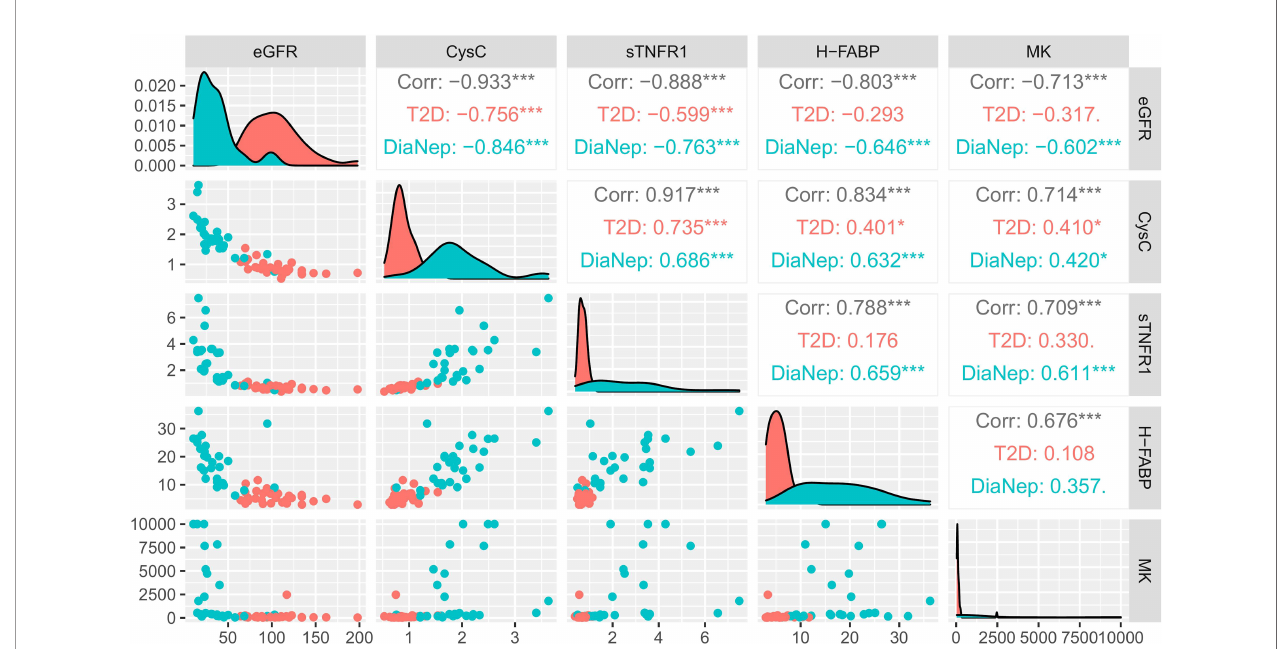
FIGURE 3 | Correlation matrix chart for signi fi cant serum biomarkers (T2D vs. DN) and eGFR. Scatterplots of each pair of numeric variable are drawn on the left part of the fi gure. Spearman ’ s rho correlations are displayed on the right. Variable distributions are shown on the diagonal. The results are coloured by cohort, i.e., T2D (red), DN (green) and both groups combined (grey). Correlations ≥ 0.7 were considered signi fi cant. Stars of signi fi cance *p<0.05,